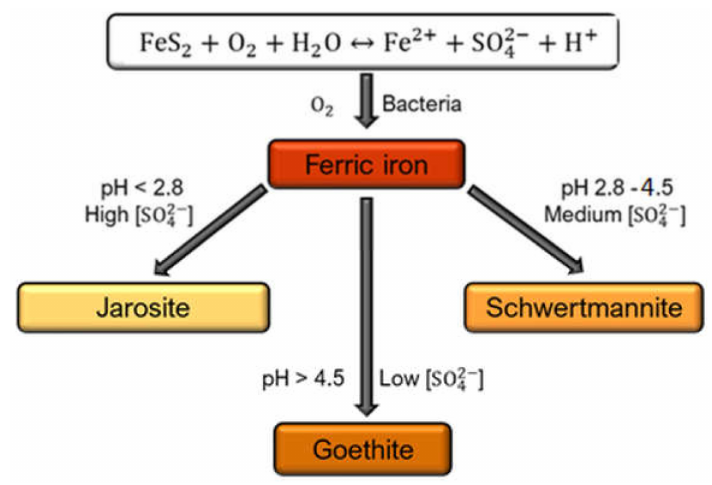
Figure 1. Mineral phase formation depending on acidity and sulfate